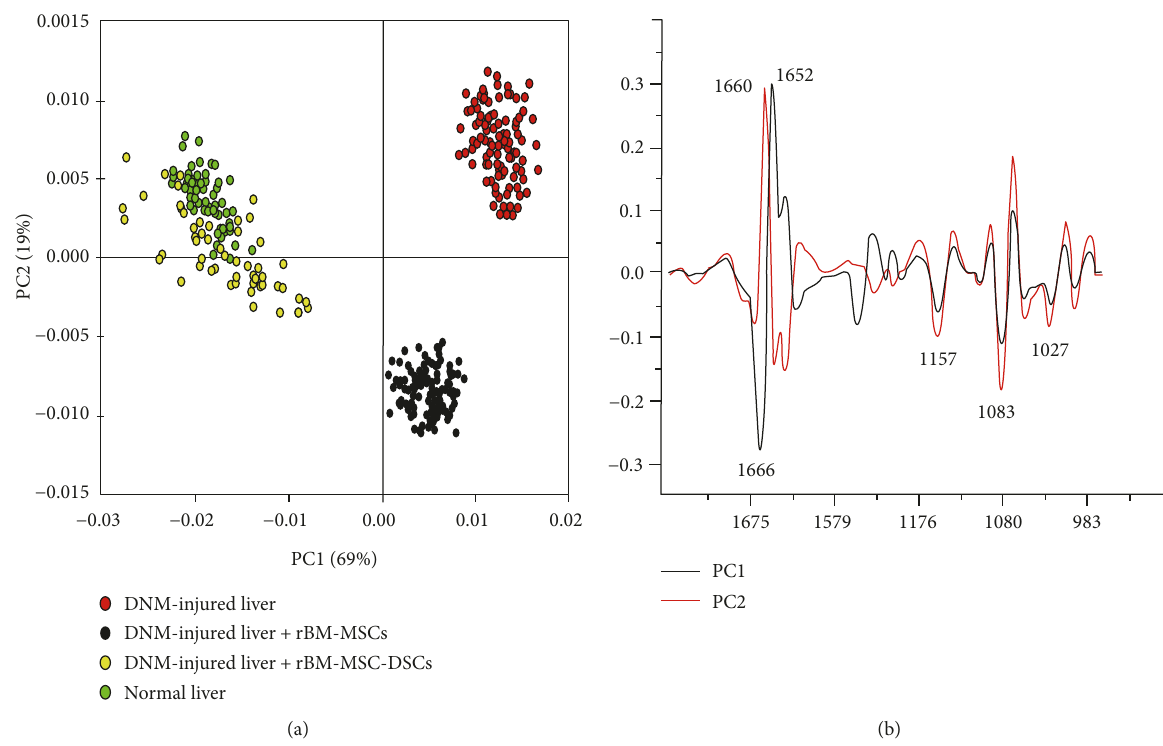
Figure 6: Principal component analysis (PCA) score plots (a) and loading plots (b). Spectra were processed to the 2nd derivative over the spectral range between 1770 – 1500 cm − 1 and 1190 – 970 cm − 1 prior to PCA. Average spectra for DNM-injured liver ( n = 85 ), DNM-injured liver +rBM-MSCs ( n = 85 ), DNM-injured liver +rBM-MSC-DSCs ( n = 85 ), and normal liver ( n = 85 ) from N = 3 rats for each experiment. Each point on the score plot represents a mean spectrum, with each calculated from 12 spectra. Principal component 1 (PC1) is a vector in the direction of the greatest variance in the data set (explaining 69% of total variance), and principal component 2 (PC2) is in the direction of the next major source of variance (explaining 19% of total variance) that is independent to variance explained by PC1. The loadings plots show which spectral bands were most responsible for the clustering observed in the scores